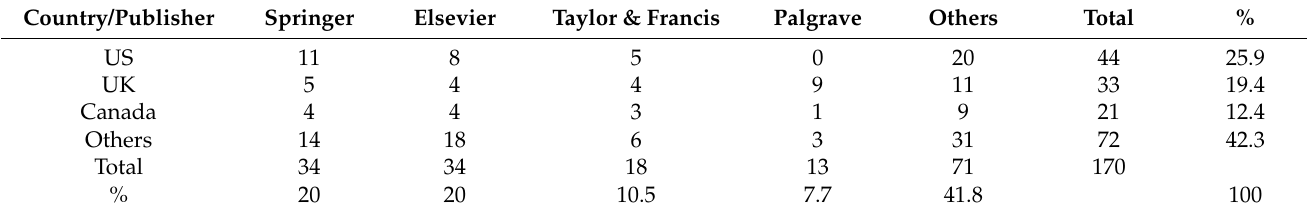
Table 6. DES publications classified by main publishers and